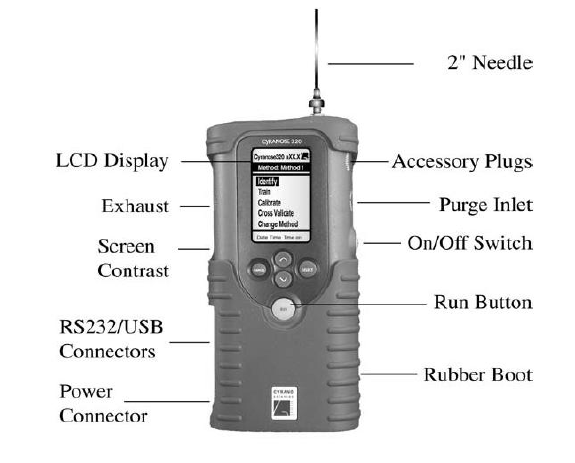
Figure 1. The Cyranose 320 [4].